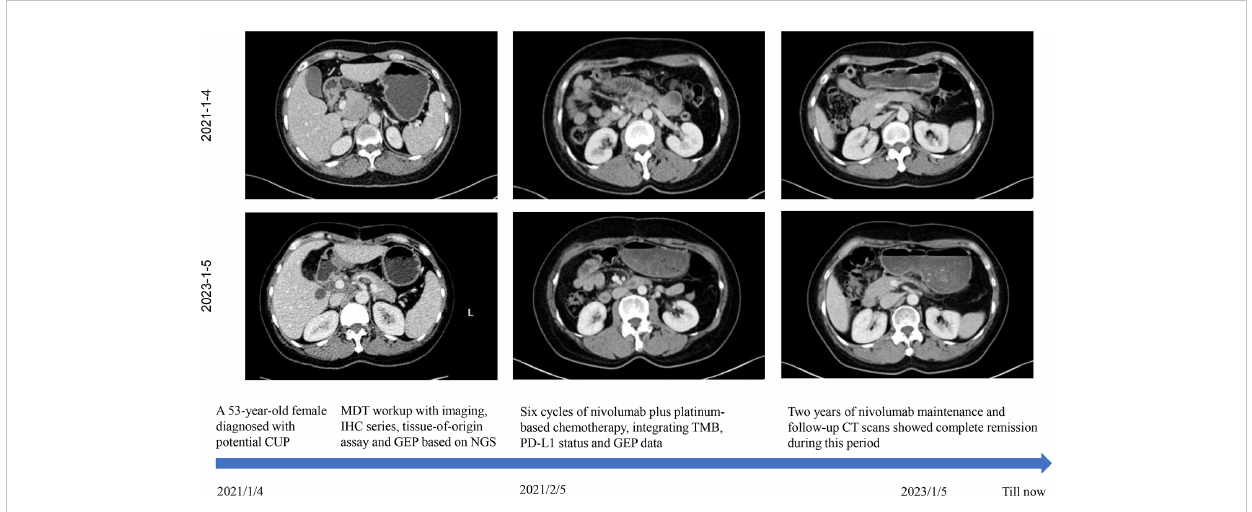
FIGURE 3 The patient ’ s clinical course schedule. Computed tomography scans of abdominal lesions at baseline (upper line) and after treatment (middle line) with nivolumab plus carboplatin and albumin-bound nanoparticle paclitaxel for six cycles and nivolumab maintenance. This case introduced an MDT workup with imaging, IHC series, tissue-of-origin assay, and NGS-based GEP. Immunochemotherapy incorporating TMB, PD-L1 status and GEP data bene fi ted this patient with long-lasting